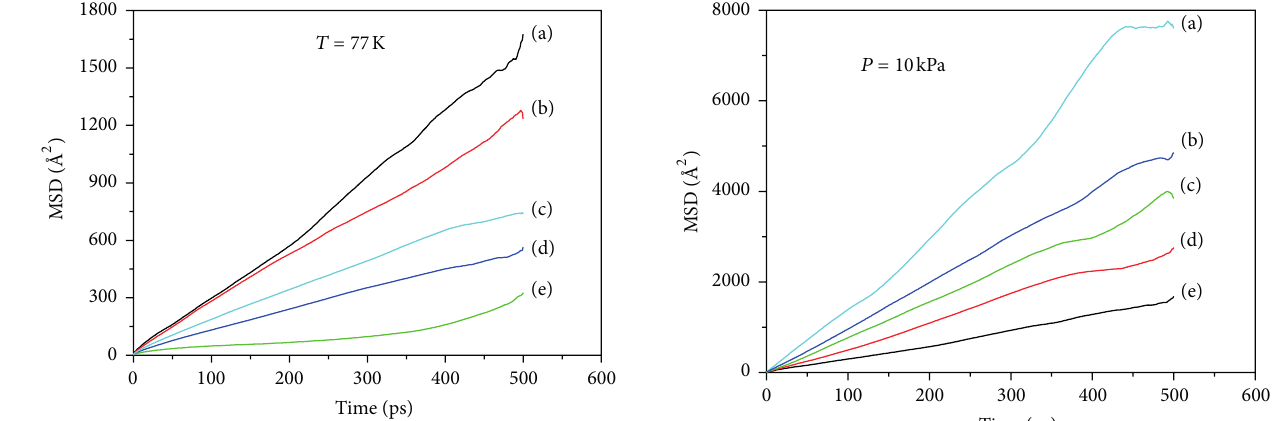
Figure 3: Mean square displacements of the center of mass of hydrogen diffusion at different temperatures: (a) 77K, (b) 160K, (c) 195 K, (d) 230 K, and (e) 293 K at